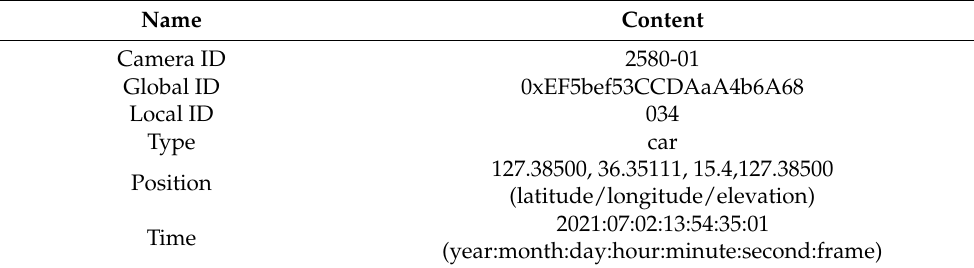
Table 2. Objectification of vehicles in a frame of closed-circuit television video.